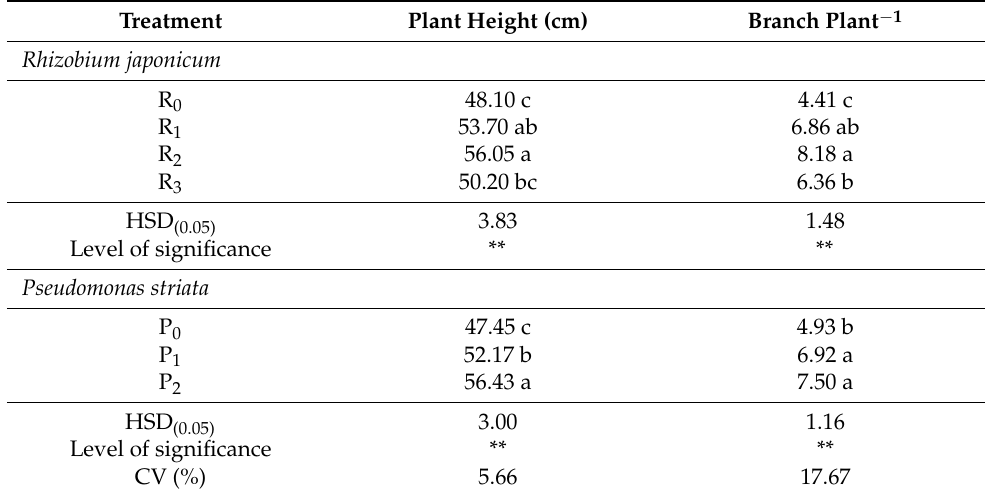
Table 2. Effect of Rhizobium japonicum and Pseudomonas striata on plant height and number of branch plant − 1 of soybean.